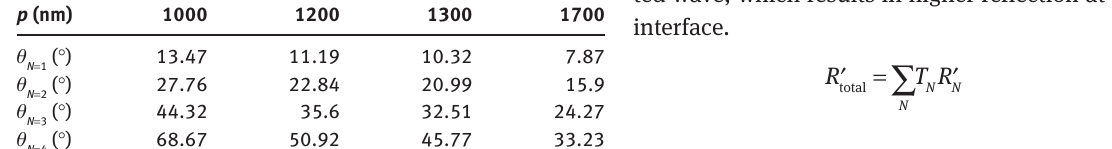
) of transmitted waves in the SOI N